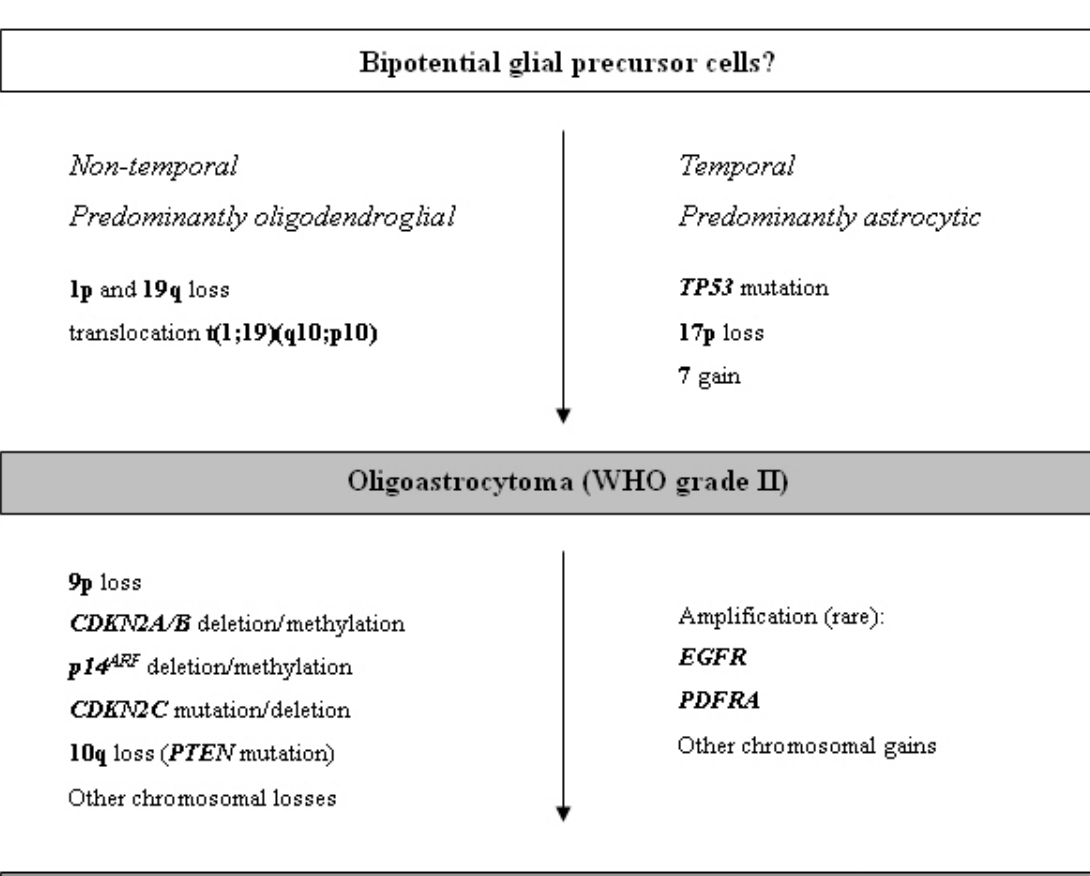
Figure 4. Schematic representation of the molecular pathogenesis and progression of